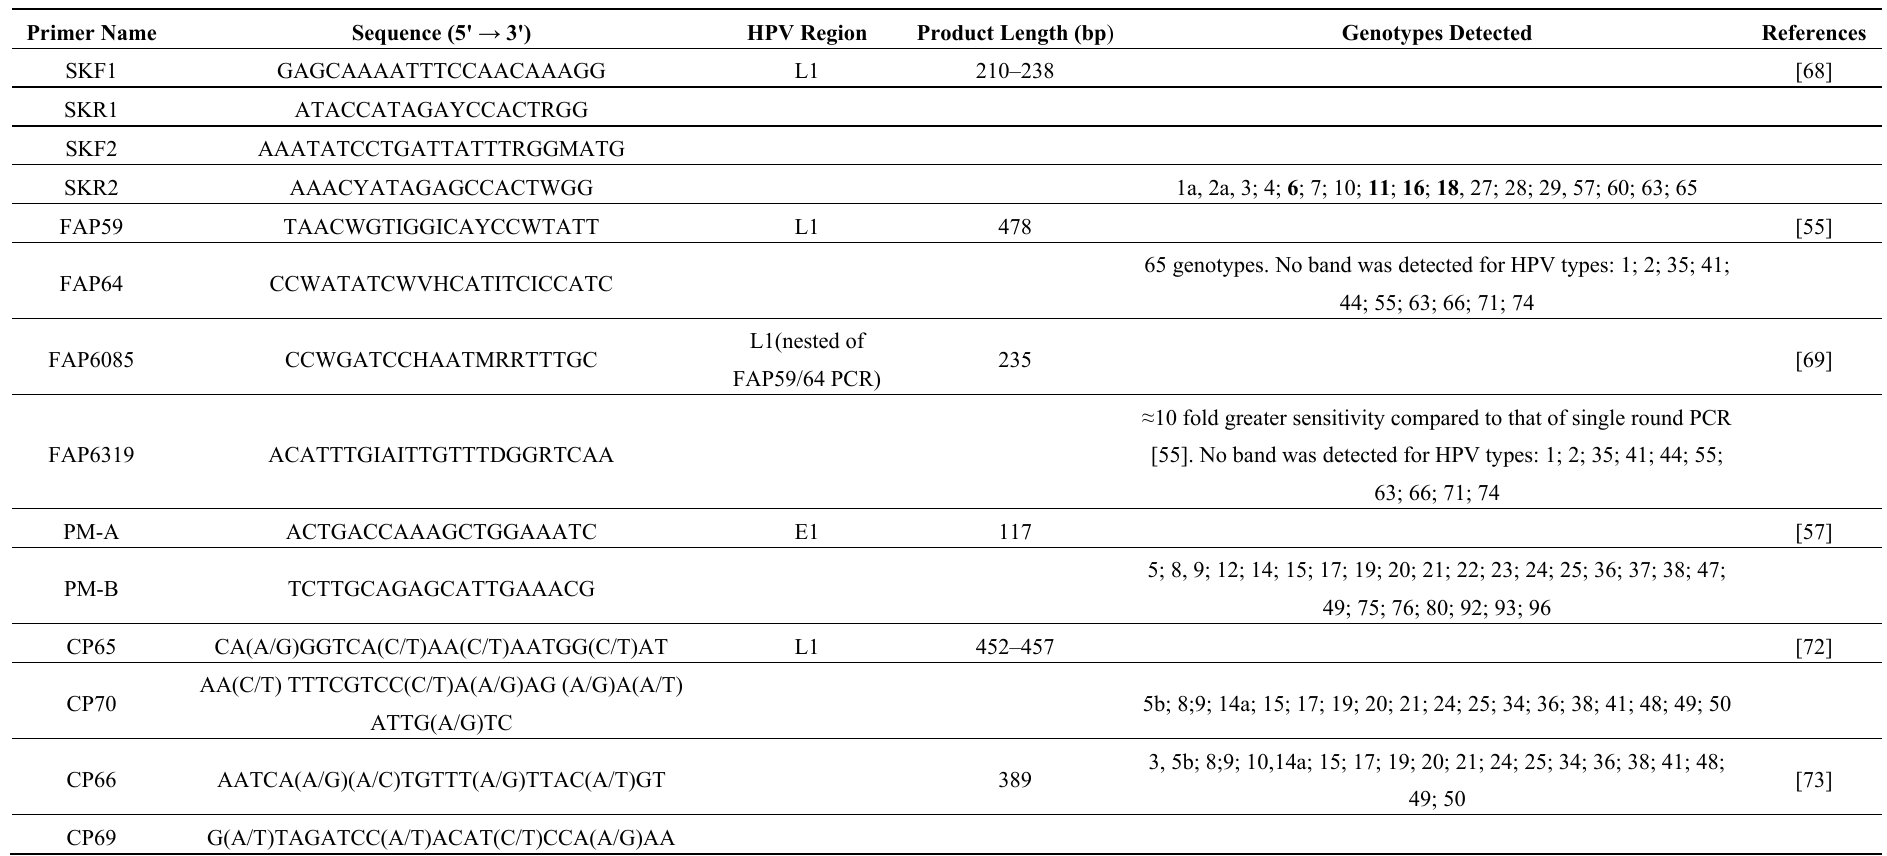
Table 2. Main PCR and primers used in beta, gamma, mu, nu HPV types